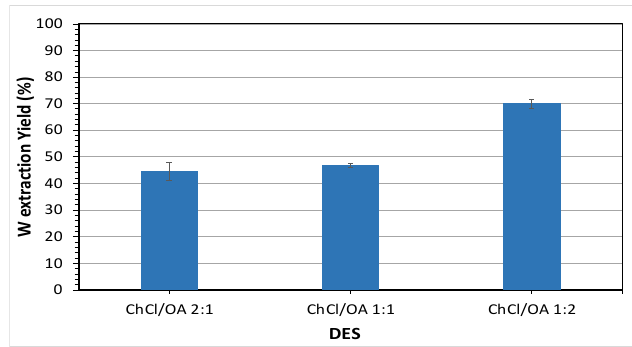
Figure 2. Effect of ChCl/OA ratio on W ext. yield (T 80 °C, L/S 10, time 24 h).